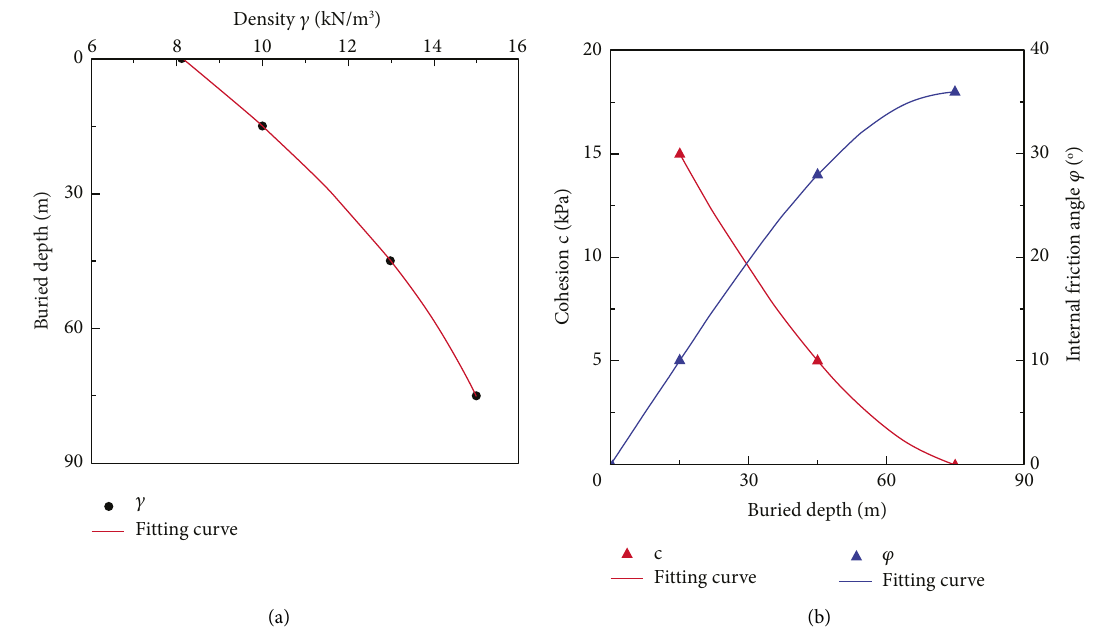
Figure 1: Variations in the landfill engineering properties with buried depth. (a) Density. (b) Shear strength. Table 4: Calculation schemes. Weight distribution Homogeneity (Table